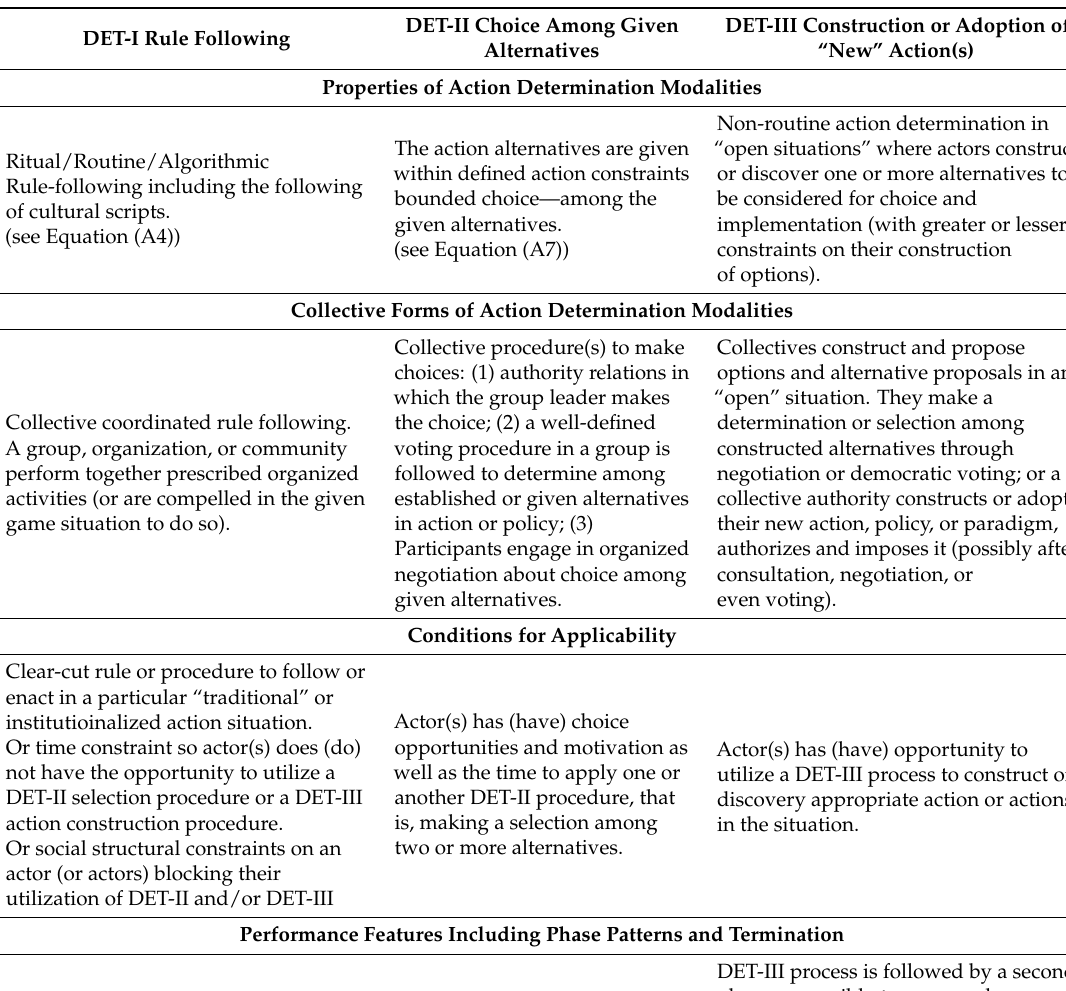
Table A1. Action Determination Modalities, Their Conditions, and Properties. DET-II Choice Among Given DET-III Construction or Adoption DET-I Rule Following